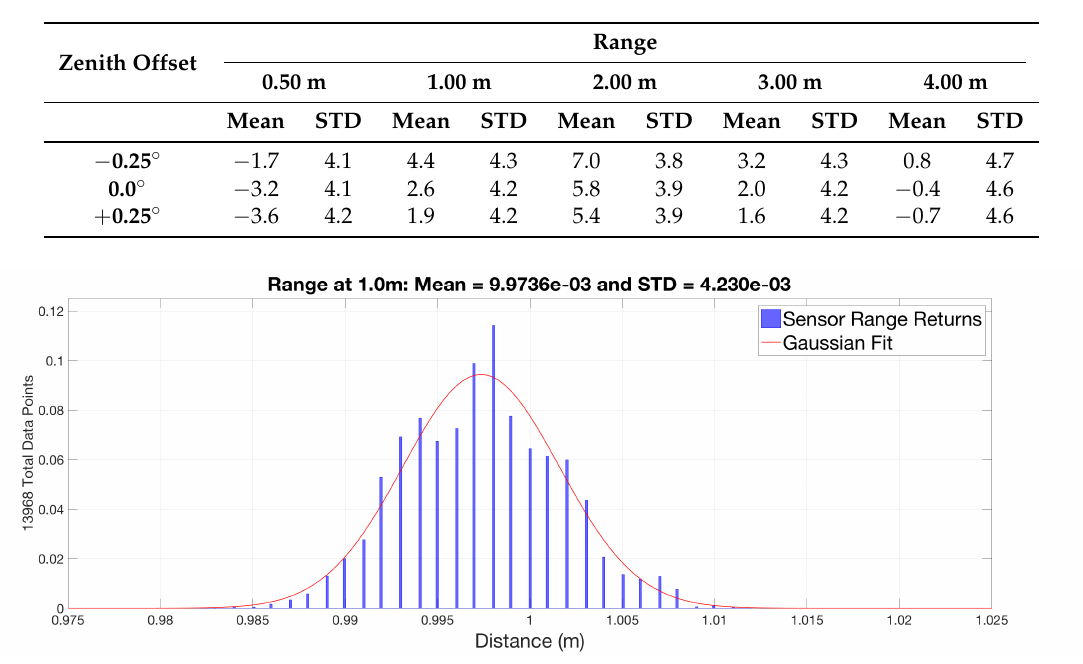
Table 2. Mean error and standard deviation from measured range in millimeters.